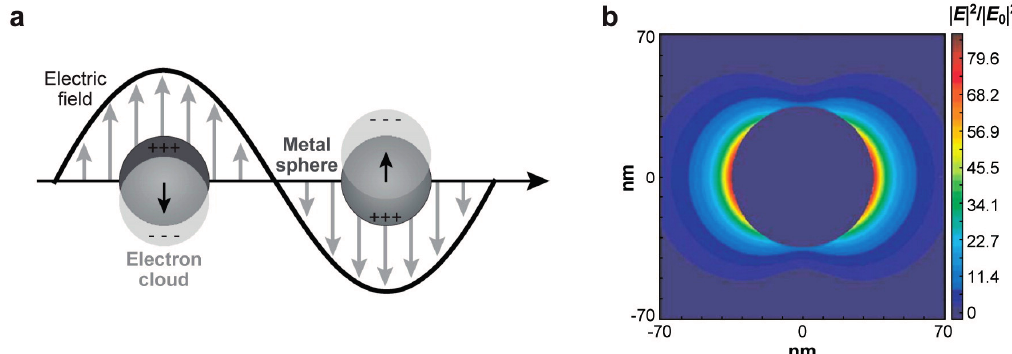
Figure 1. ( a ) Illustration of the localized surface plasmon resonance; ( b ) Extinction coefficient (ratio of cross-section to effective area) of a spherical silver nanoparticle of 35-nm in radius in vacuum. | E | 2 contours for a wavelength corresponding to the plasmon extinction maximum. Peak | E | 2 /| E 0 | 2 = 85. Reproduce with permission from